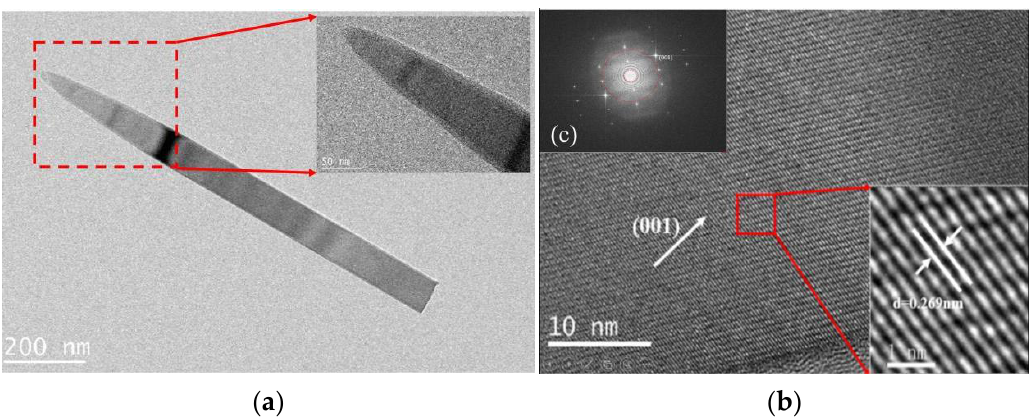
Figure 11. TEM ( a ) HR-TEM ( b ) and SAED ( c ) images of mullite whiskers prepared by sintering at 825 °C for 5